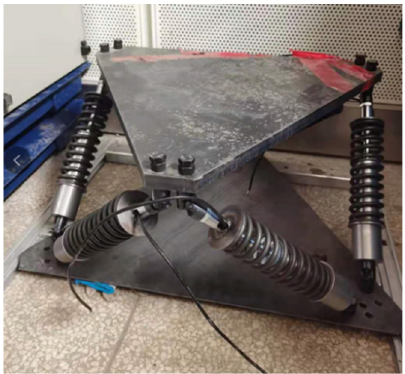
Figure 16. Experimental prototype of multi-DOF seat damping suspension.